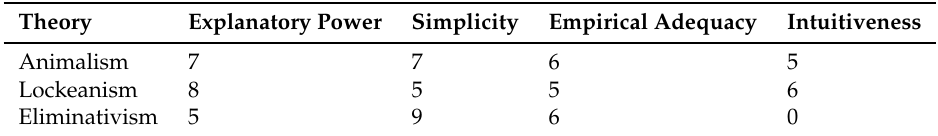
Table 4. Theory choice in